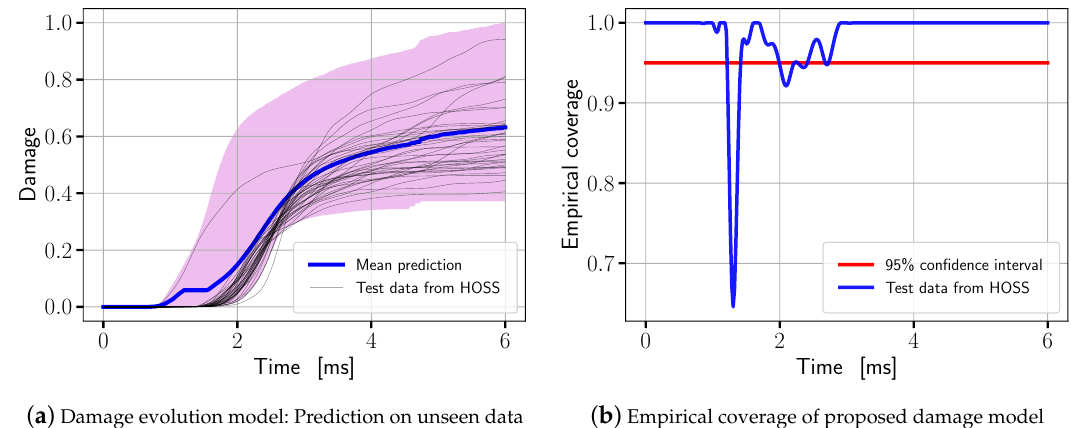
Figure 10. Damage statistics: The above figure provide the estimated damage and empirical coverage on data from 40 unseen HOSS simulations. From these two figures, it is clear that for most of the times we have more than 90% prediction